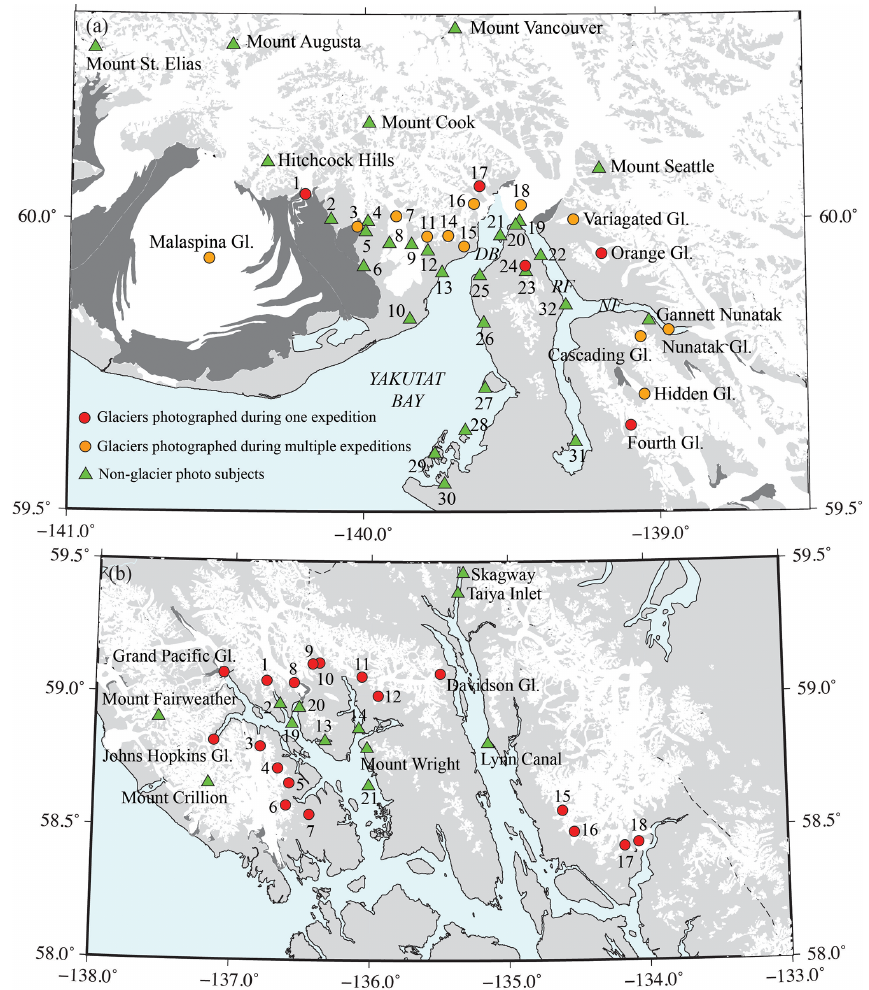
Figure 2. Sites visited in southeast Alaska. (a) Sites visited in Yakutat Bay. DB is Disenchantment Bay, RF is Russell Fjord, and NF is Nunatak Fjord. Numbered locations are (1) Marvine Gl., (2) Blossom Island, (3) Hayden Gl., (4) Floral Hills, (5) Floral Pass, (6) Kwik Stream, (7) Lucia Gl., (8) Lucia Stream, (9) Terrace Point, (10) Strawberry Island, (11) Atrevida Gl., (12) Ampitheater Knob, (13) Esker Stream, (14) Galianao Gl., (15) Black Gl., (16) Turner Gl., (17) Haenke Gl., (18) Hubbard Gl., (19) Osier Island, (20) Gilbert Point, (21) Haenke Island, (22) Marble Point, (23) Mt. Alexander, (24) Alexander Gl., (25) Indian Camp, (26) Logan Beach, (27) Knight Island, (28) Otmeloi Island, (29) Khantaak Island, (30) Yakutat, (31) Cape Stoss, and (32) Cape Enchantment. (b) Sites visited in Glacier Bay. Numbered locations are (1) Rendu Gl., (2) Rendu Inlet, (3) Reid Gl., (4) Hugh Miller Gl., (5) Charpentier Gl., (6) Geike Gl., (7) Wood Gl., (8) Carroll Gl., (9) Morse Gl., (10) Muir Gl., (11) McBride Gl., (12) Casement Gl., (13) Tidal Inlet, (14) Muir Inlet, (15) Herbert Gl., (16)